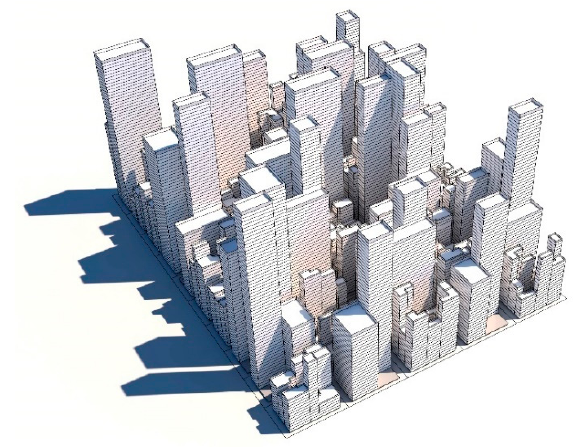
Figure 7. The primitive phenotype for the design problem.